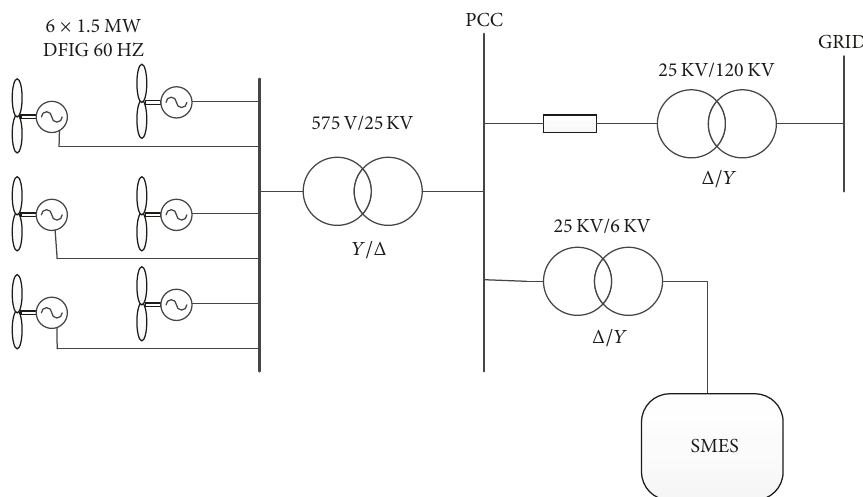
Figure 13: Single-line diagram showing SMES connection for reactive power compensation [15].